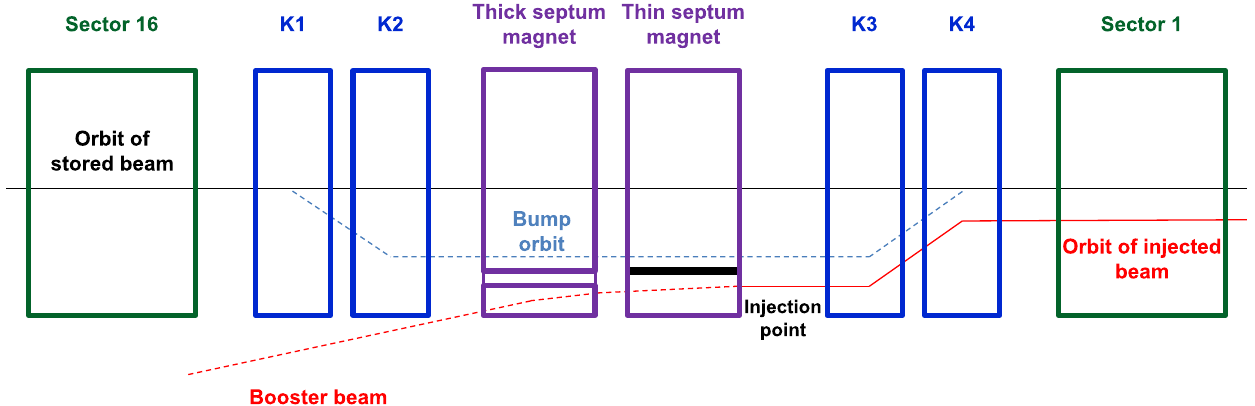
FIG. 3. Standard bump-based injection scheme. The stored beam is bumped (blue dashed line) from the central orbit (black solid line) by the four kickers (blue squares), in the injection section. The booster beam (red dotted line) is brought parallel to the stored beam by the septum magnets (in purple). Eventually, the stored beam is brought back to the central orbit with the injected beam (red solid line), as the orbit bump falls.